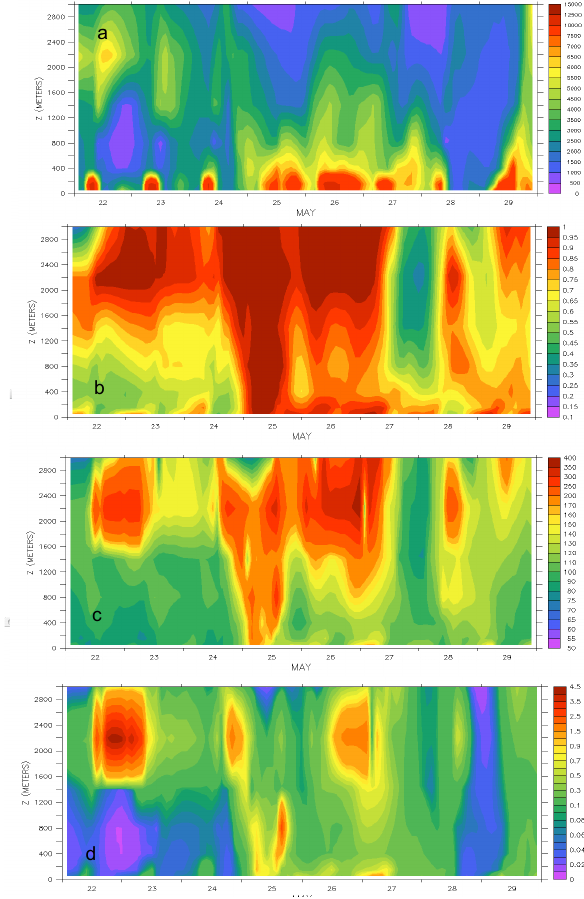
Fig. 9. (a) Fine mode particle concentration (cm − 3 ) , (b) RH, (c) Figure 9. a) Fine mode particle concentration (cm -3 ), b) RH, c) median wet radius of the soluble accumulation mode (nm), and d) the scattering coefficient (km -1 ) simulated for the median wet radius of the soluble accumulation mode (nm), and (d) moist (May 22-26) and dust periods (May 27-30). the scattering coefficient (km − 1 ) simulated for the moist (22–26 May) and dust periods (27–30